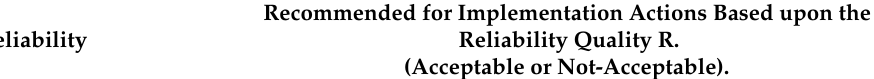
Table 16. Proposed decision matrix for how to act upon the assessed confidence in the reliability of assigned seismic performance level of the building R